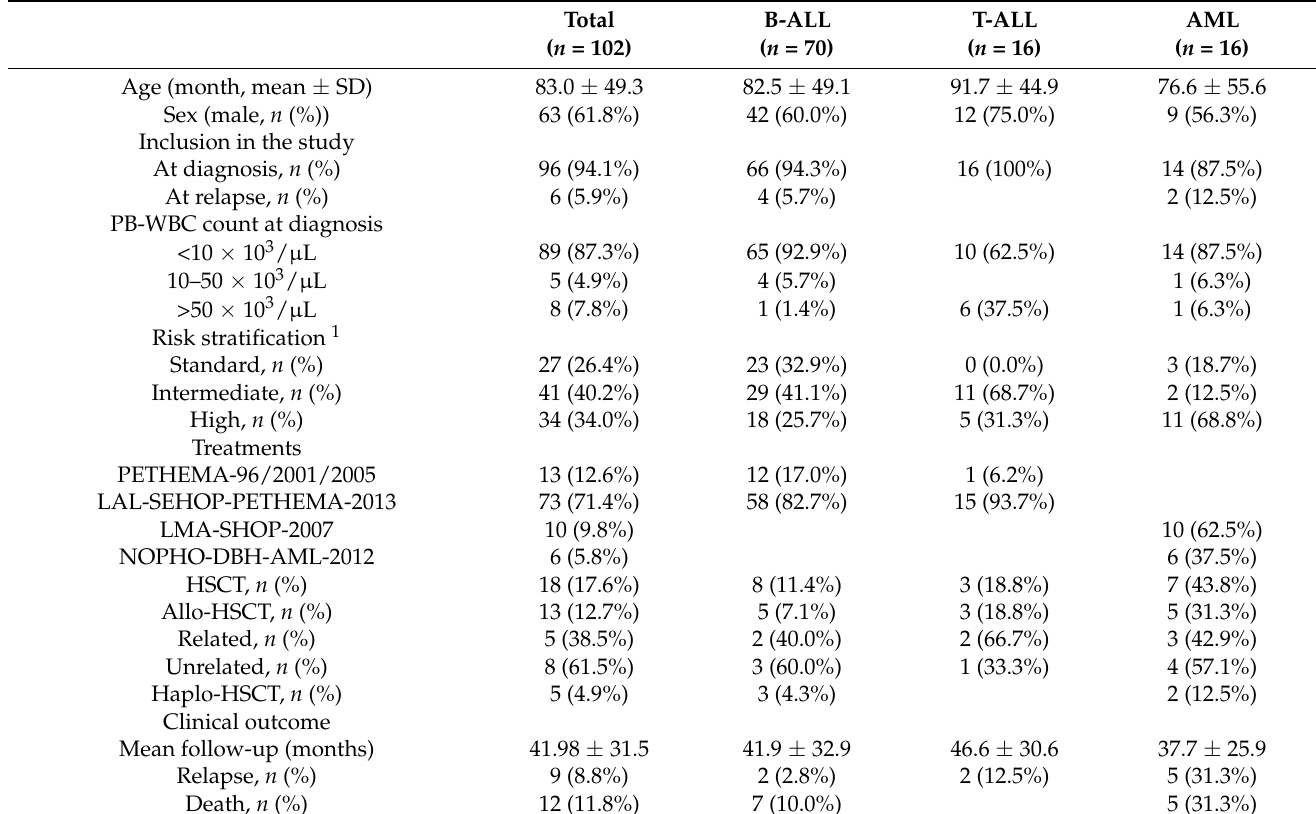
Table 1. Biological, clinical, therapeutic, and evolutionary features of